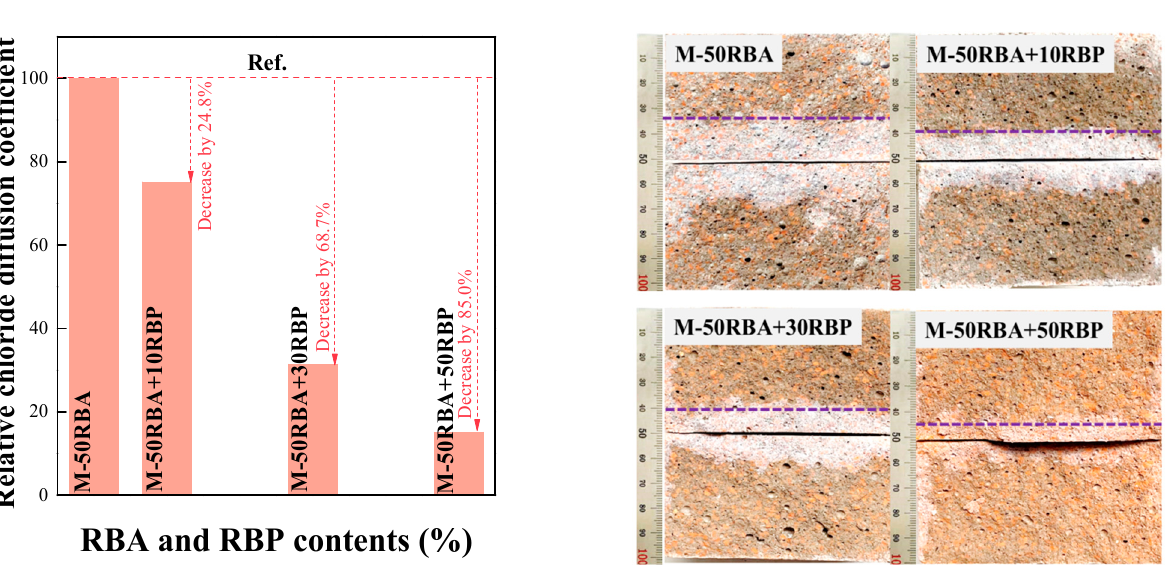
Figure 14. Chloride ingress in cement mortar with RBA and RBP.